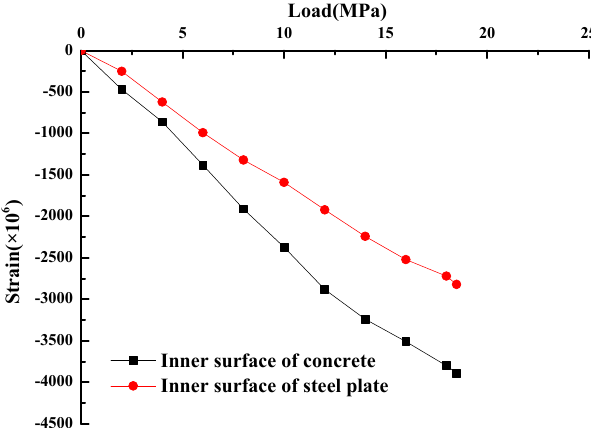
Figure 7. Load–hoop strain curves of model ZJ6.